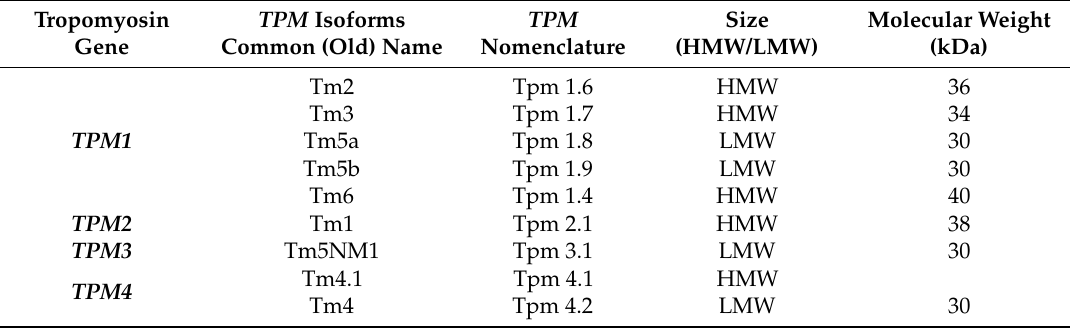
Table 1. Distribution of molecular weight over well-characterized tropomyosin (TPM) isoforms and genes. HMW: high molecular weight; LMW: low molecular